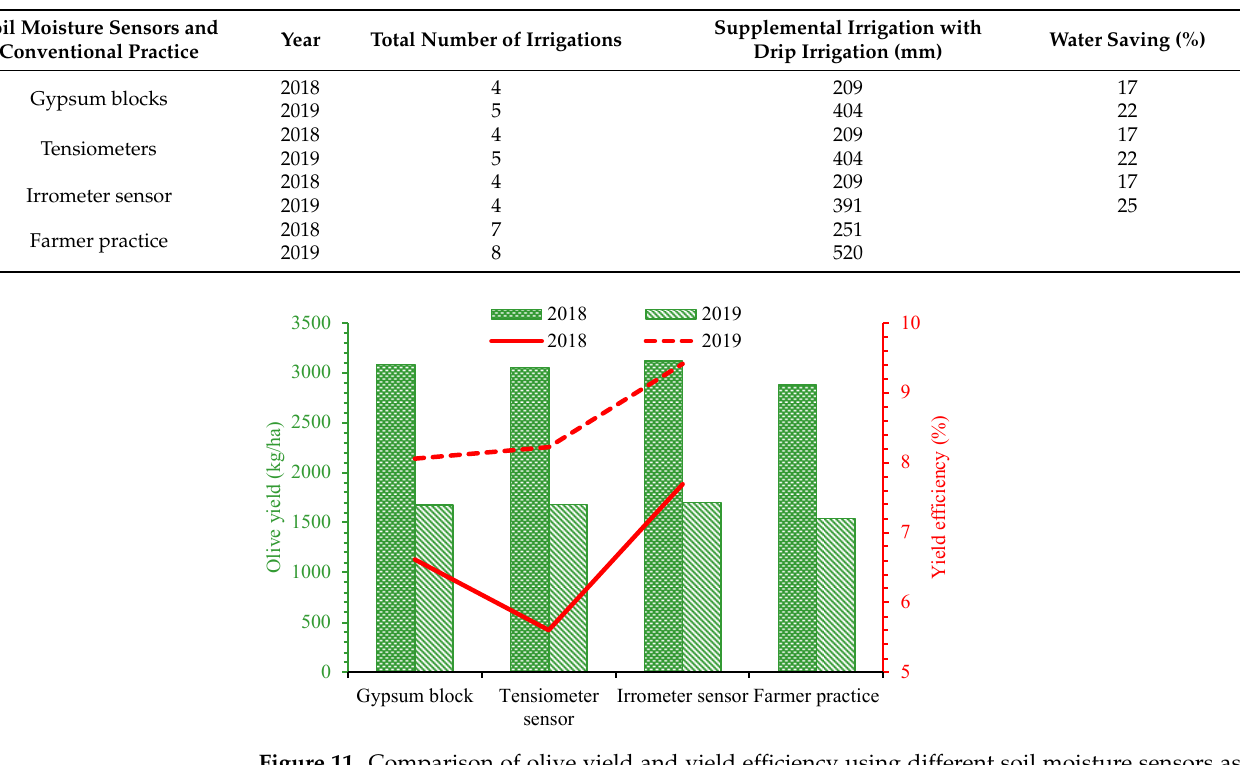
Table 5. Amounts of supplemental irrigation, number of irrigations, and water saving potential achieved using different soil moisture sensors.